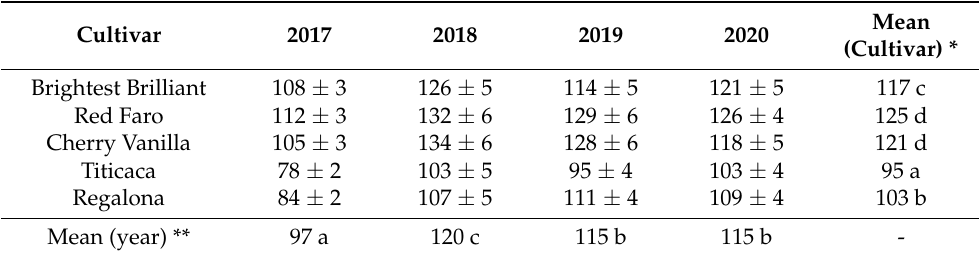
Table 3. Quinoa height (cm) before the harvest. Cultivar